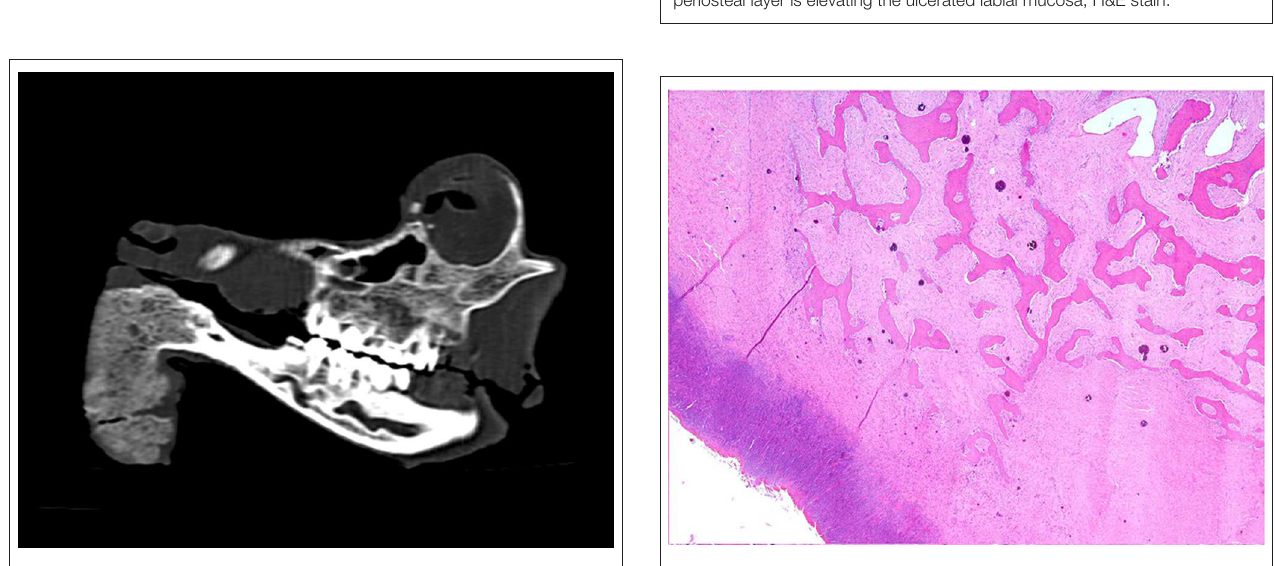
FIGURE 4 | Head, roe deer; computed tomography scan showing the contiguity of the bony mass with the mandible and the effacement of the latter by the tumor. This figure features a single sagittal MPR (multi-planar reconstruction) image through the skull at the level of the tumor.